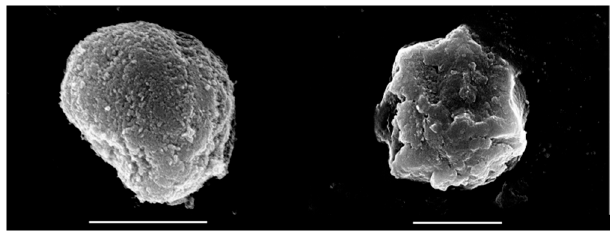
Figure 4. SEM micrograph of LDH (left) and EA-LDH (right) at 25,000 × and 18,000 × magnification, respectively. Scale bars represent 2 μ m.